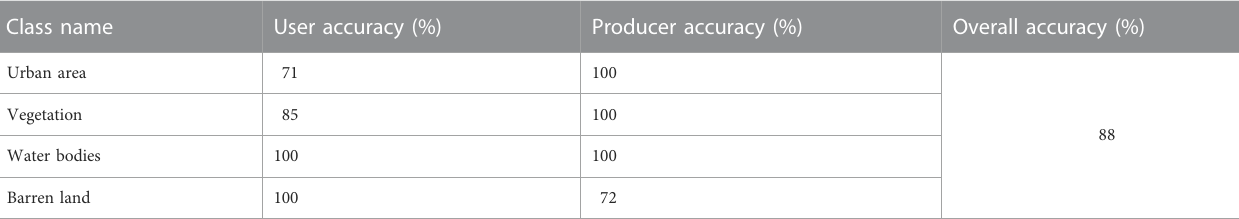
TABLE 5 Accuracy assessment of land use